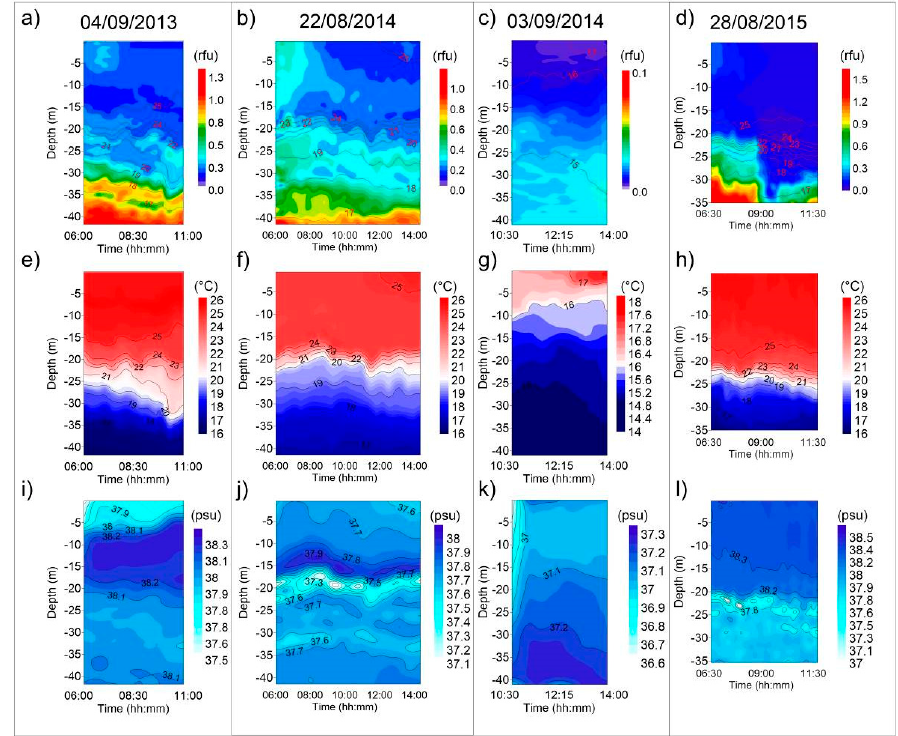
Figure 7. ( a ) Time series of Fluorescence of chlorophyll a ( a – d ) expressed in rfu (relative fluorescence units), Temperature ( e – h ), and Salinity ( i – l ) at station 1.